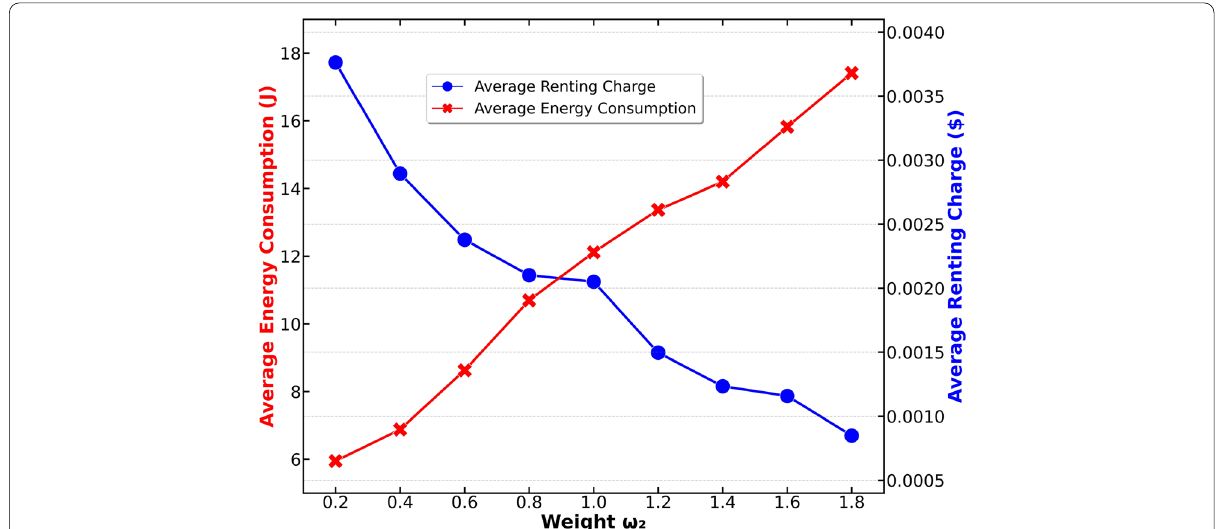
Fig. 5 Energy consumption and renting charge vs weight ω